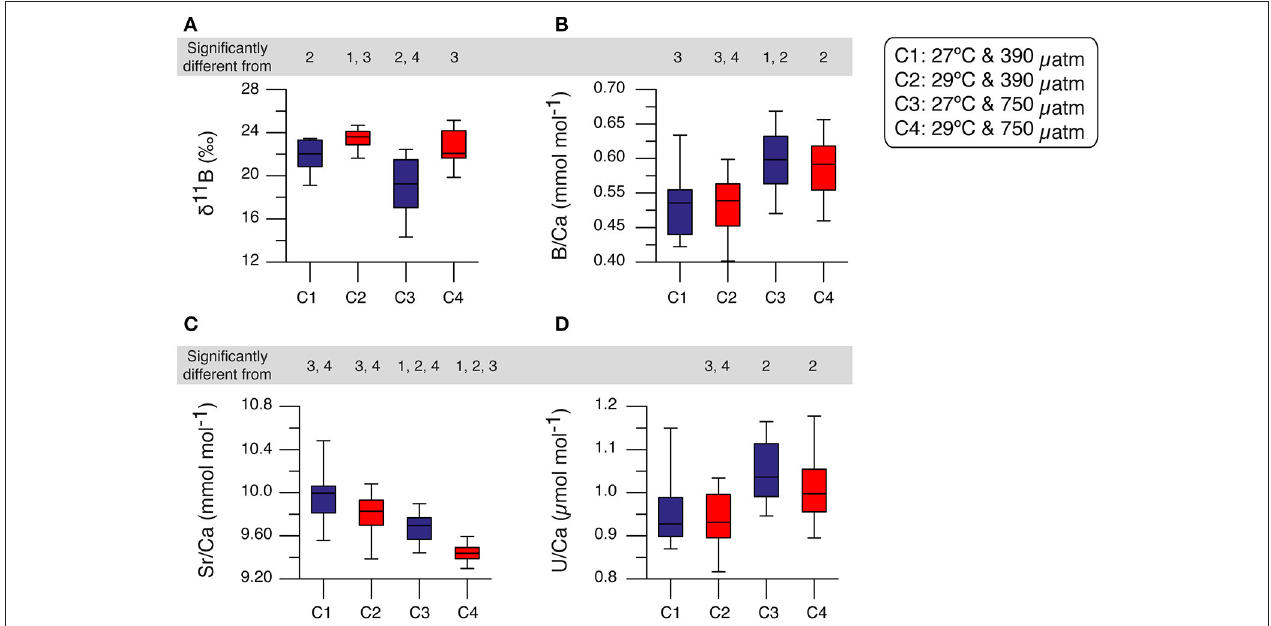
FIGURE 5 | Box-whisker plots of the primary polyp A. millepora juvenile corals geochemical results. In each plot from left to right are the respective experimental conditions (e.g., Condition 1, C1). (A) δ 11 B ( ‰ ), (B) B/Ca (mmol mol − 1 ), (C) Sr/Ca (mmol mol − 1 ), and (D) U/Ca ( µ mol mol − 1 ). The box plots represent the lower and upper quartiles with the median shown as a horizontal line within each box. The top and bottom whiskers extending from the box plots represent the highest and lowest values respectively. The mean and analytical errors for the NIST SRM 610 and JCp-1 standards measured by LA-ICP-MS are – B/Ca: 17.402 ± 0.394mmol mol − 1 (2.27% RSD; NIST 610) and 0.577 ± 0.056mmol mol − 1 (9.67% RSD; JCp-1); Sr/Ca: 3.041 ± 0.032mmol mol − 1 (1.06% RSD; NIST 610)